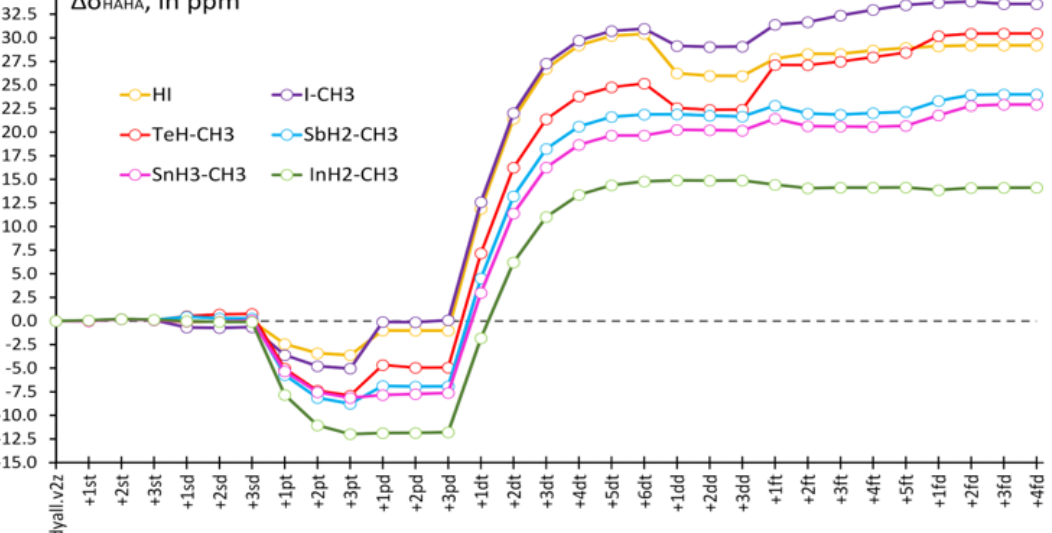
Figure 4. Relative changes of the HAHA effects in model compounds 1 – 6 upon saturation of the basis set on the heavy atom with respect to the corresponding starting values, calculated using the unsaturated dyall.v2z basis set.